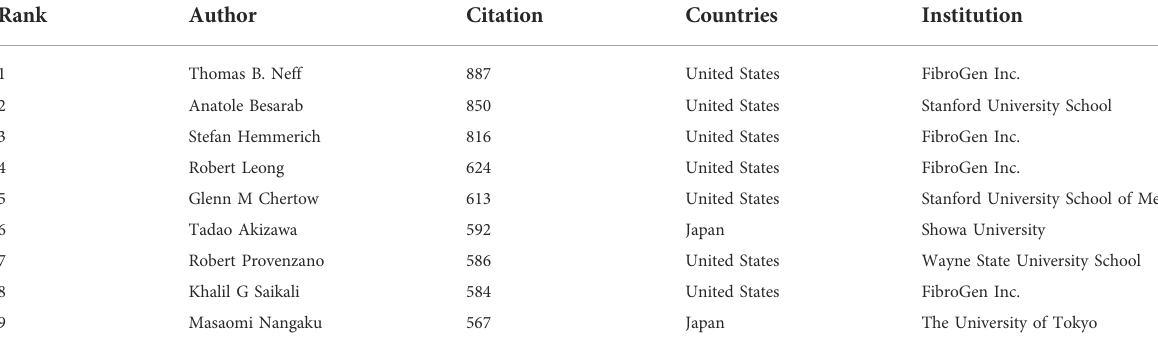
TABLE 2 Nationality and working place of the top 10 co-cited authors.